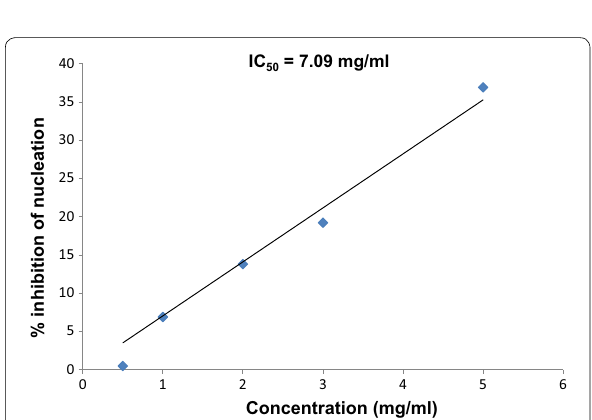
Fig. 2 Percentage inhibition of aqueous methanolic extract of Triclisia gilletii on turbidity in nucleation